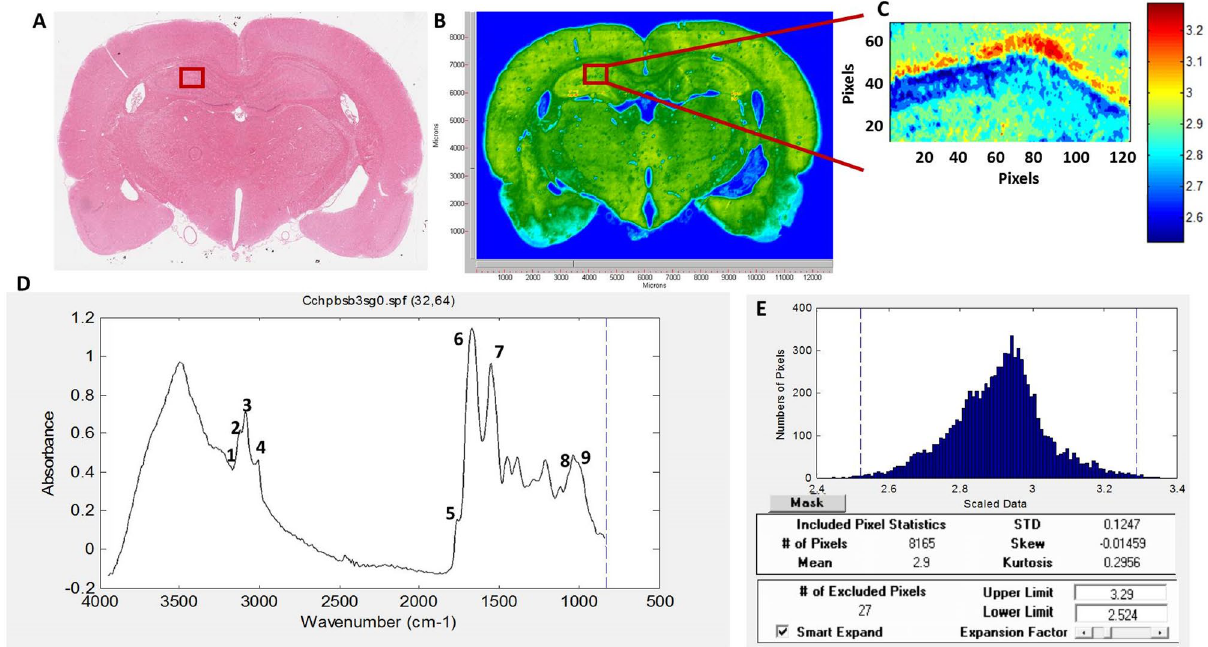
Figure 1. ( A ) Histological image of an H&E stained brain section. ( B ) Representative FTIRI of the rat brain tissue shown in ( A ) with a rectangular label in hippocampal area indicating anatomic site examined by FTIRI. ( C ) Typical FTIR image from the rectangular labeled area before spectral processing. ( D ) The average spectra of hippocampal tissue of the control group in 4000–800 cm −1 region (The spectra were normalized with respect to the Amide A band). ( E ) The pixel histogram for the image shown in ( C